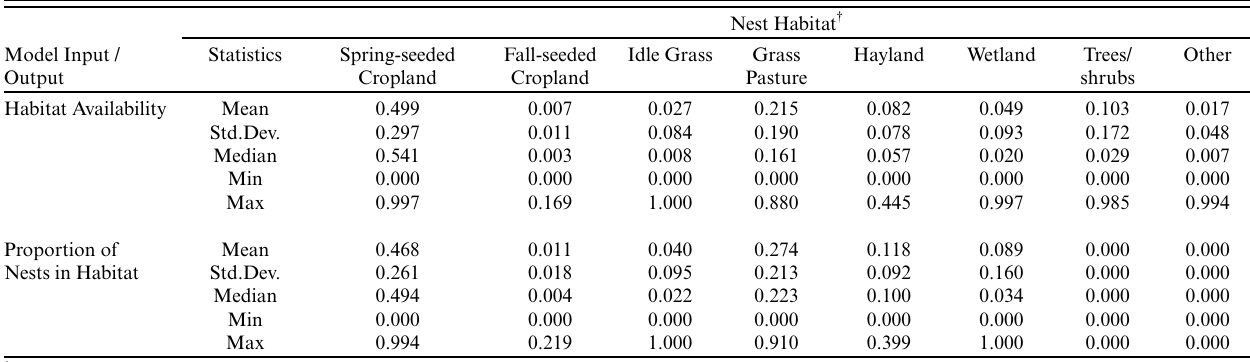
Table 1 . Summary of statistics for habitat availability (productivity model input) and proportion of Northern Pintail ( Anas acuta ) nests in each habitat (productivity model output) across 41-km² grid cells (n = 13,285) covering the Canadian portion of the Prairie Pothole